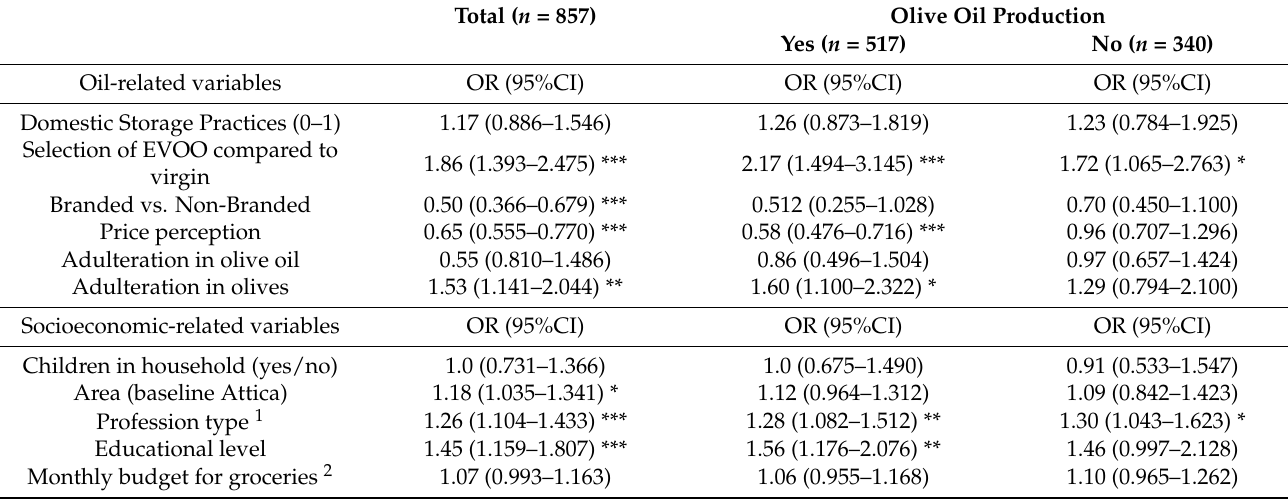
Table 2. Minimally adjusted logistic regression (for sex and age) of Consumer Knowledge Score association with type of oil consumed and domestic storage practices in total population and by olive oil production status.